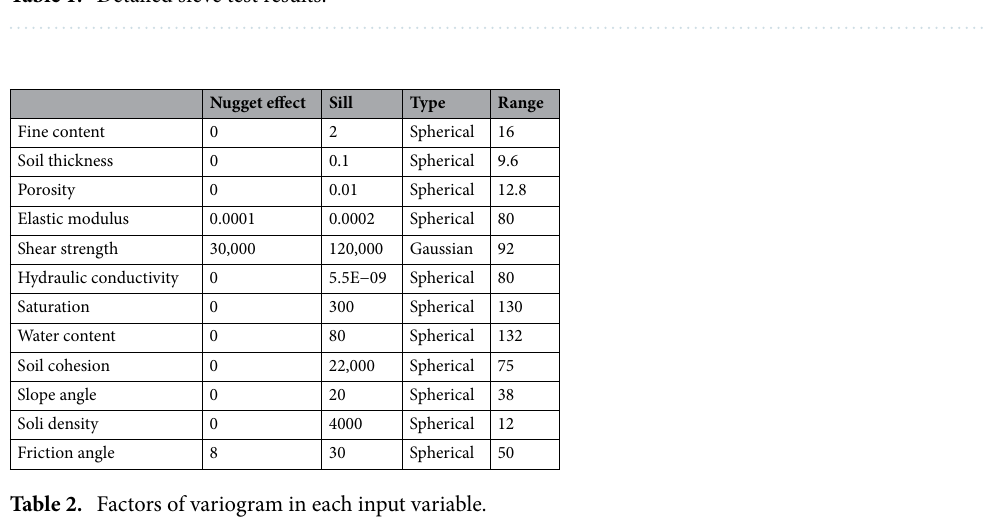
Table 1. Detailed sieve test results.